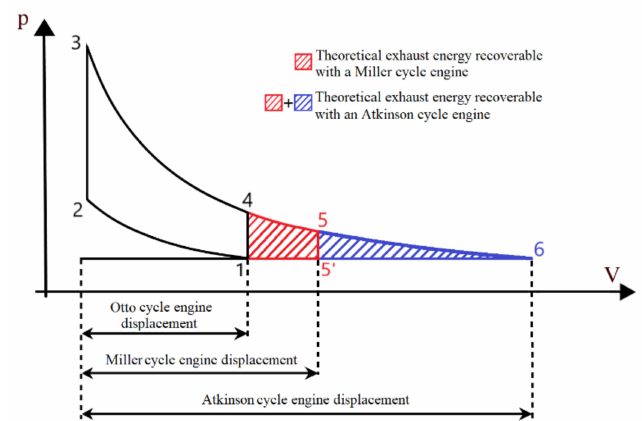
Figure 1. Comparison between the Otto, Miller and Atkinson